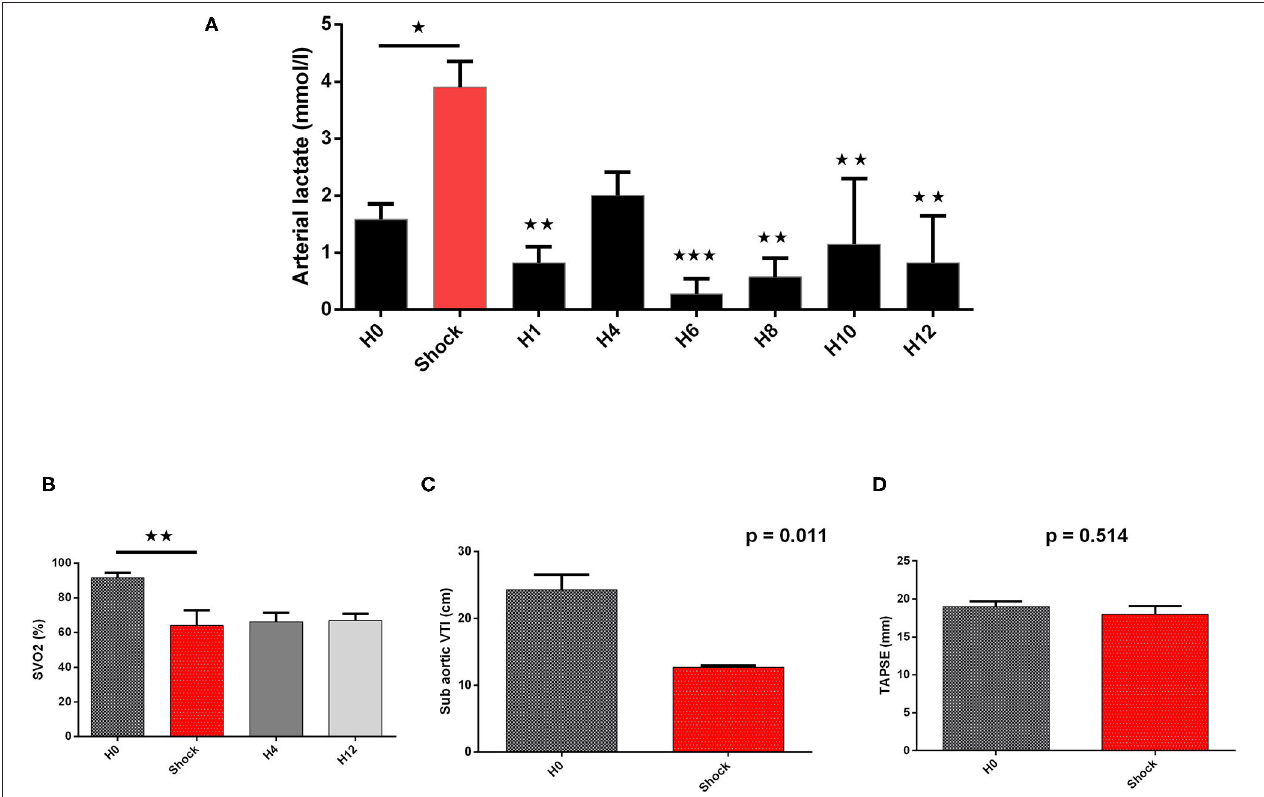
FIGURE 4 | Biological and echographical markers of cardiogenic shock (CS) evolution. Lactate and SVO 2 are presented at baseline (H0), at CS onset, and after IVAC2L implantation as mean ± SEM ( n = 4). The values of p were obtained by comparing each point to CS point for arterial lactate and SVO 2 . Echographical parameters (TAPSE and sub-aortic VTI) were recorded at baseline and at CS onset before IVAC2L implantation and are reported as mean ± SEM. The values of p were obtained by comparing sub-aorticVTI and TAPSE. ⋆ p < 0.05; ⋆⋆ p < 0.01, and ⋆⋆⋆ p < 0.001 vs. shock. H0, baseline; H1, 1h post CS; H4, 4h after CS; H12, 12h after CS; SEM, standard error of mean; SVO 2 , venous oxygen saturation; TAPSE, tricuspid annular systolic excursion; VTI, velocity time